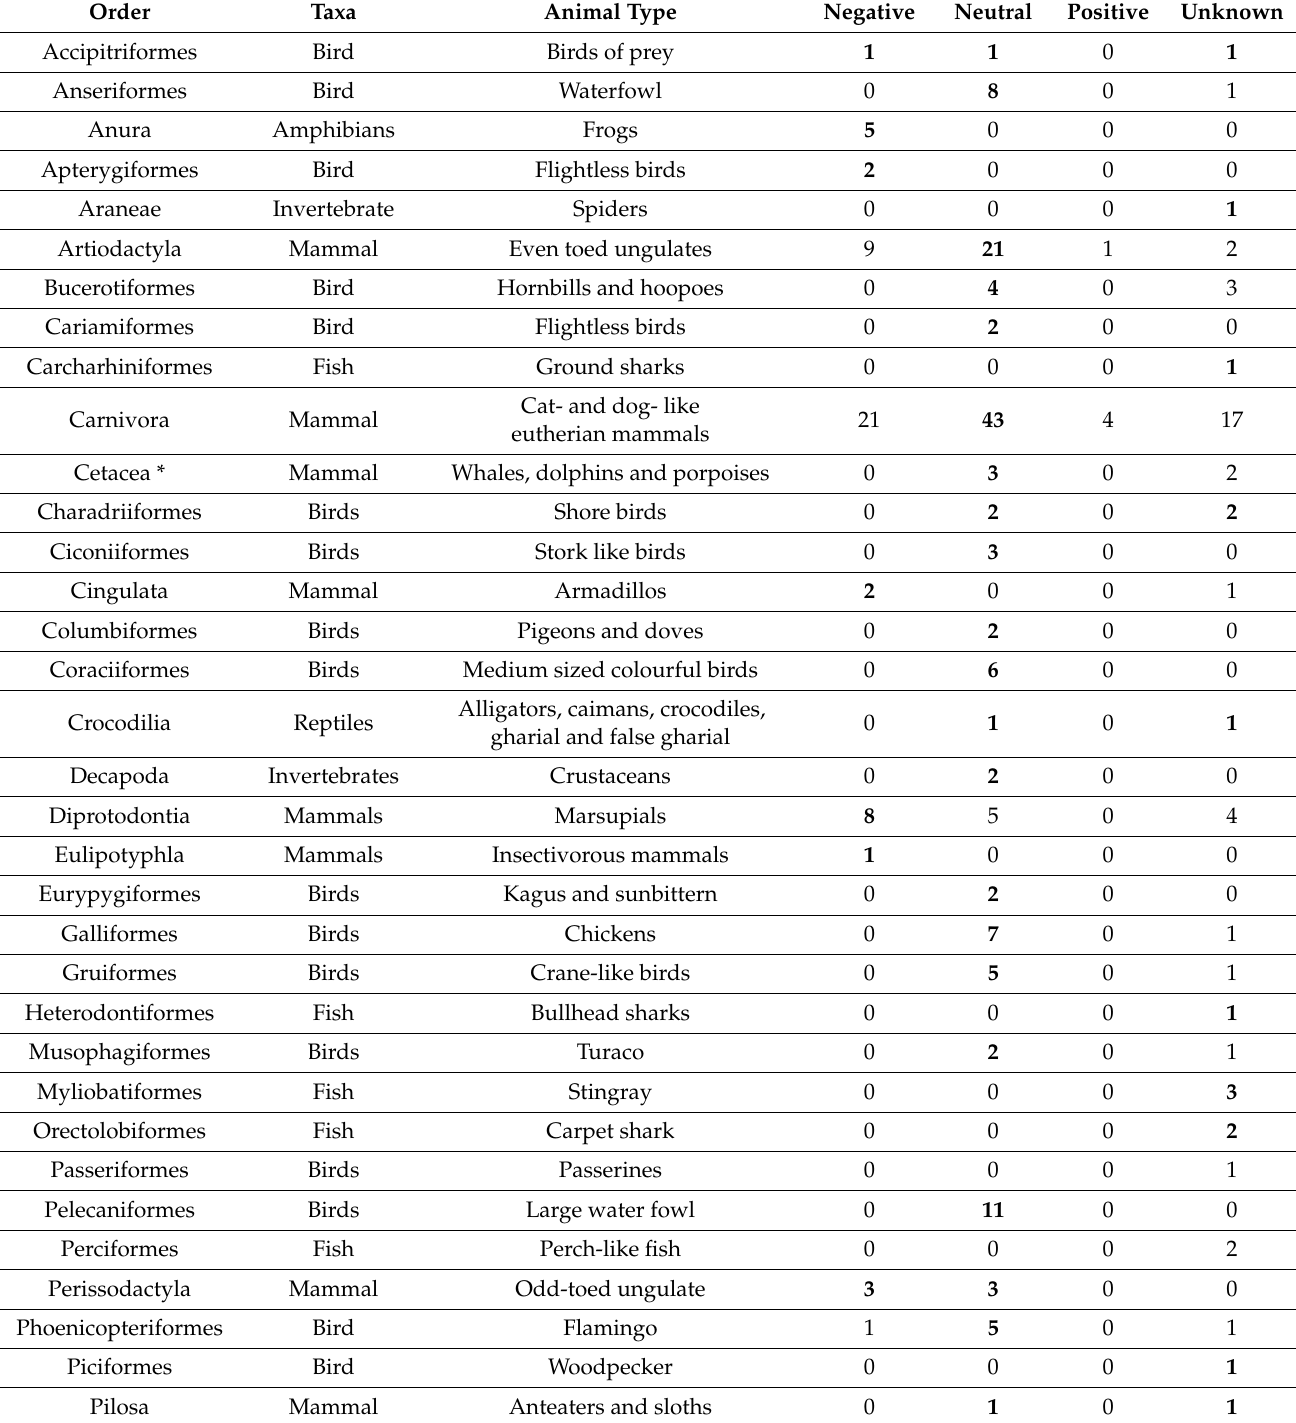
Table 2. An overview of response to visitors as a function of animal order. The most frequent behaviour response is highlighted in bold for each animal-based